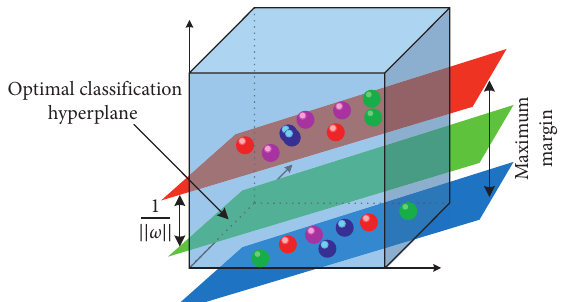
Figure 2: Schematic diagram of the optimal classification